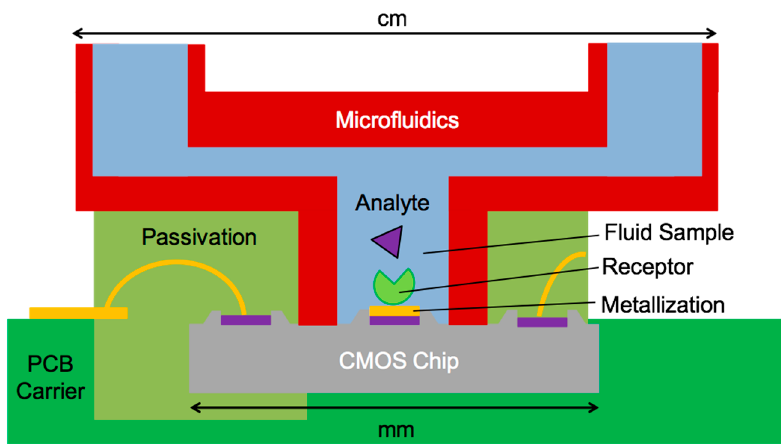
Figure 5. CMOS on-chip bio-sensing showing the critical size matching and post-fabrication steps: pad metallization, immobilization of receptor, coupling of mm-sized chips to cm-scale microfluidics and photo-patternable passivation to expose the sensing electrode.